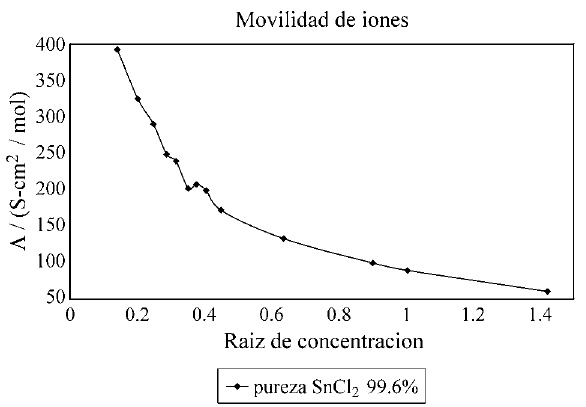
Figura 3b. Curva de conductividad molar contra la raíz cuadrada de la